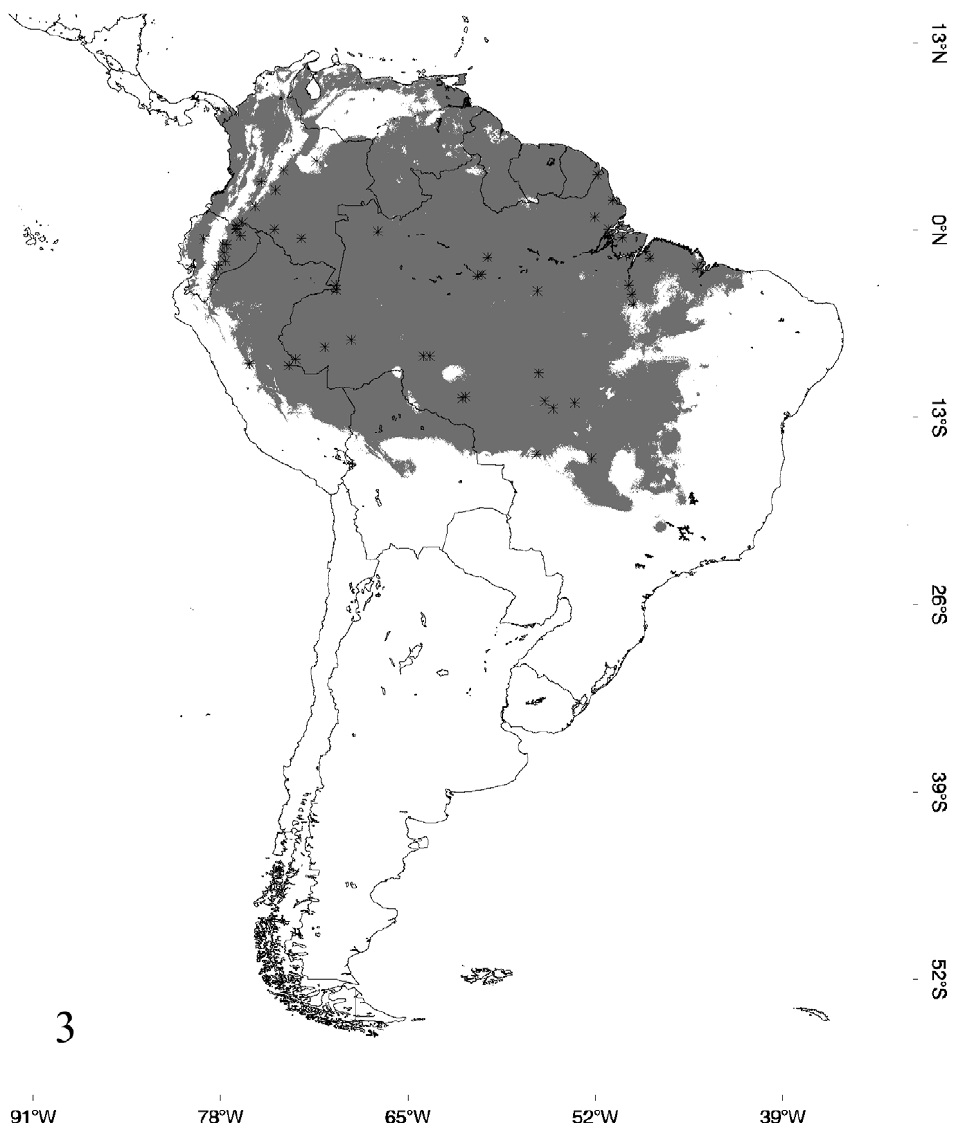
Figure 3. Occurrence probability map for Epicratesassisi , determined by its respective model and points of occurrence.